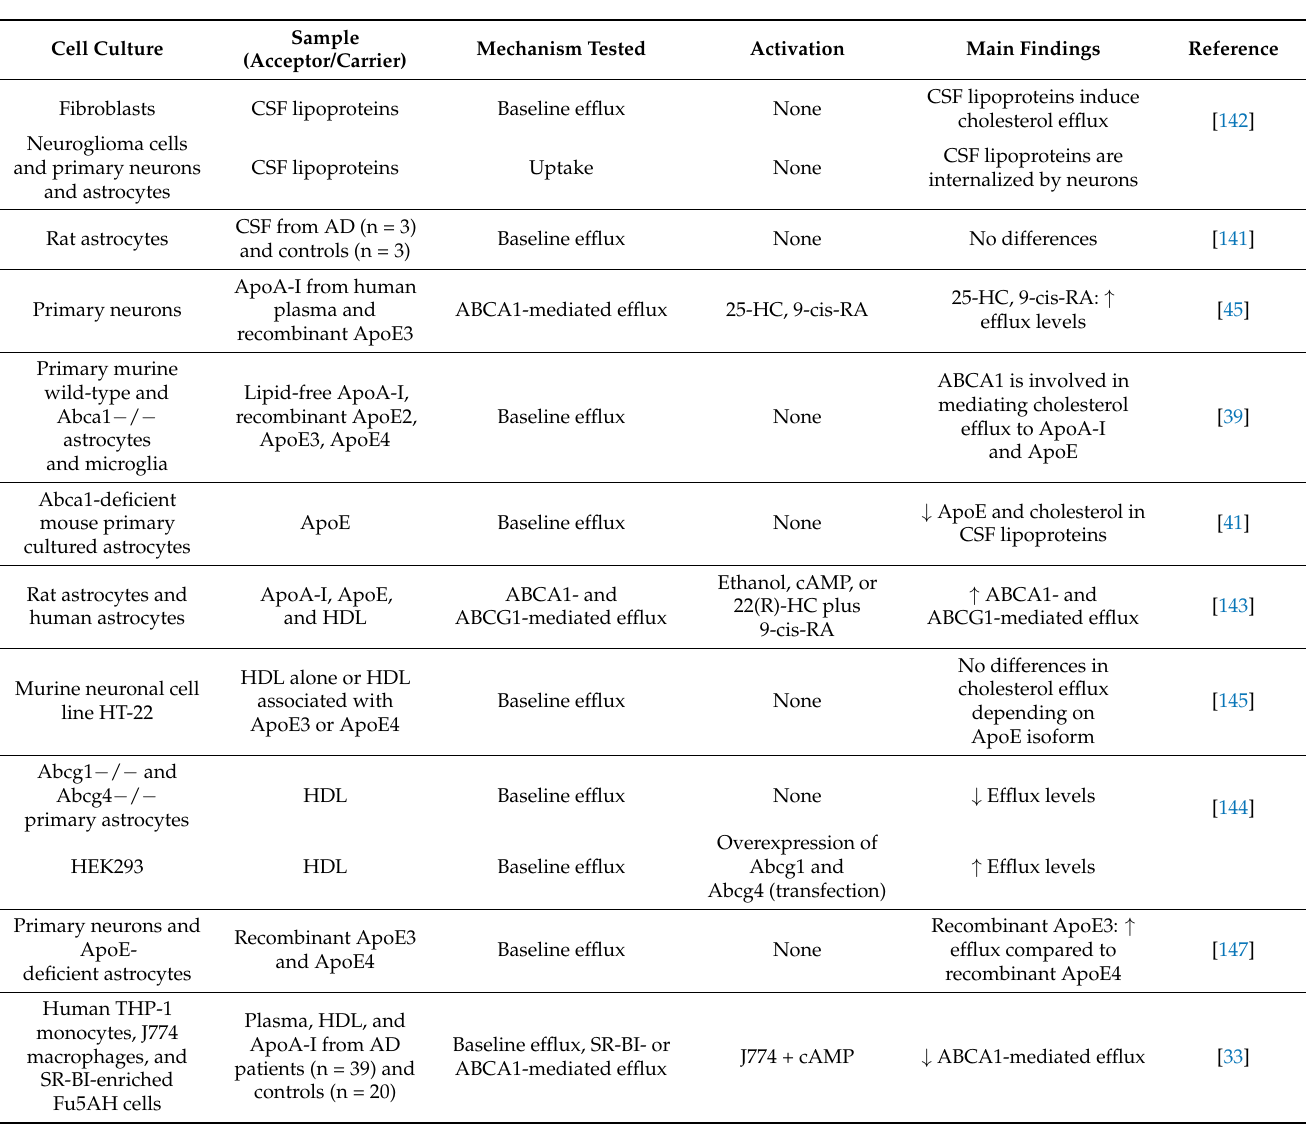
Table 3. Brain cholesterol trafficking studies. The following table includes all works explor- ing cholesterol efflux and cholesterol uptake processes regarding AD in different cell types, ordered